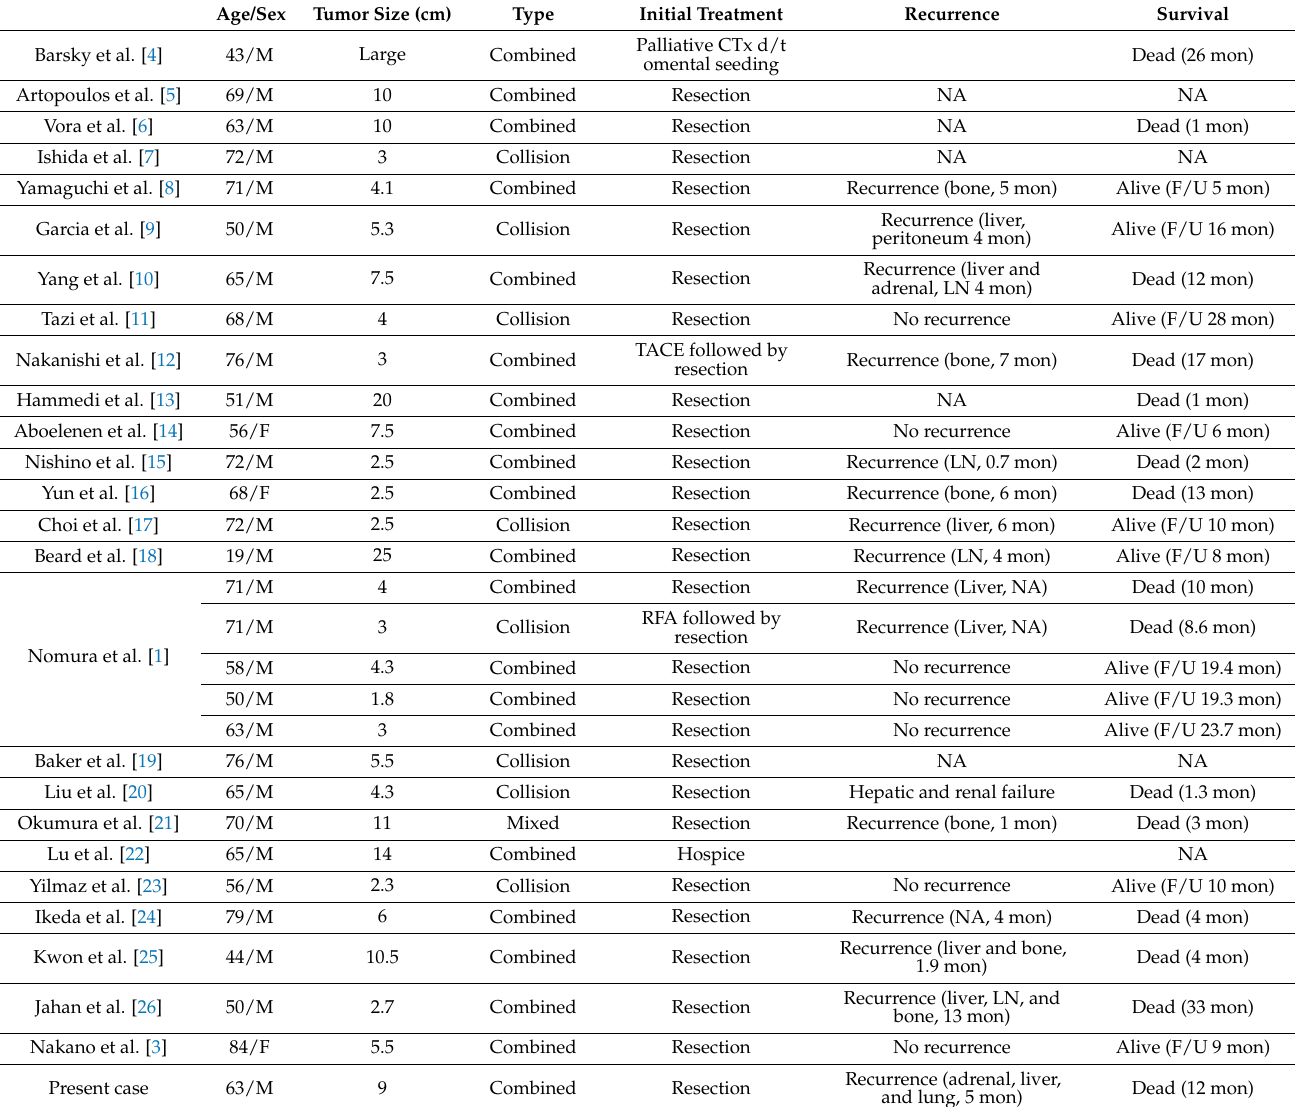
Table 1. Cases of mixed hepatocellular carcinoma and neuroendocrine